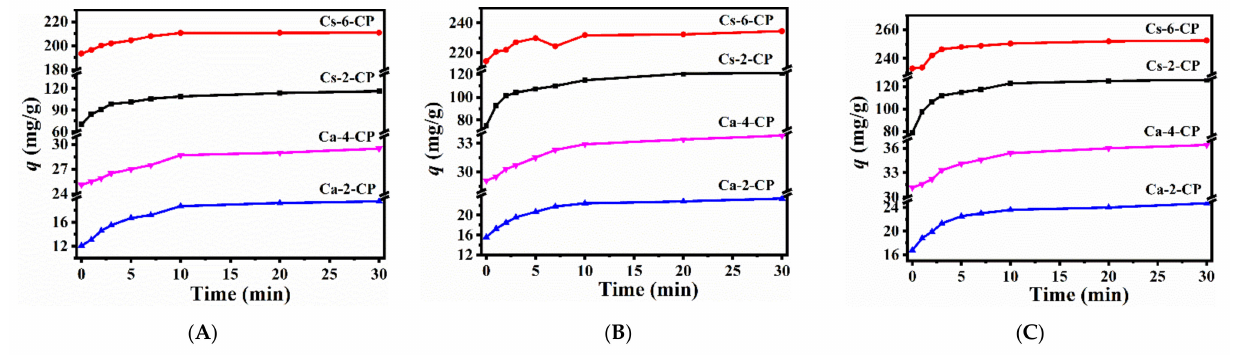
Figure 2. Exchanged kinetic behaviors of Cs–x–CP and Ca–x–CP at 313 K ( A ), 333 K ( B ), and 353 K ( C